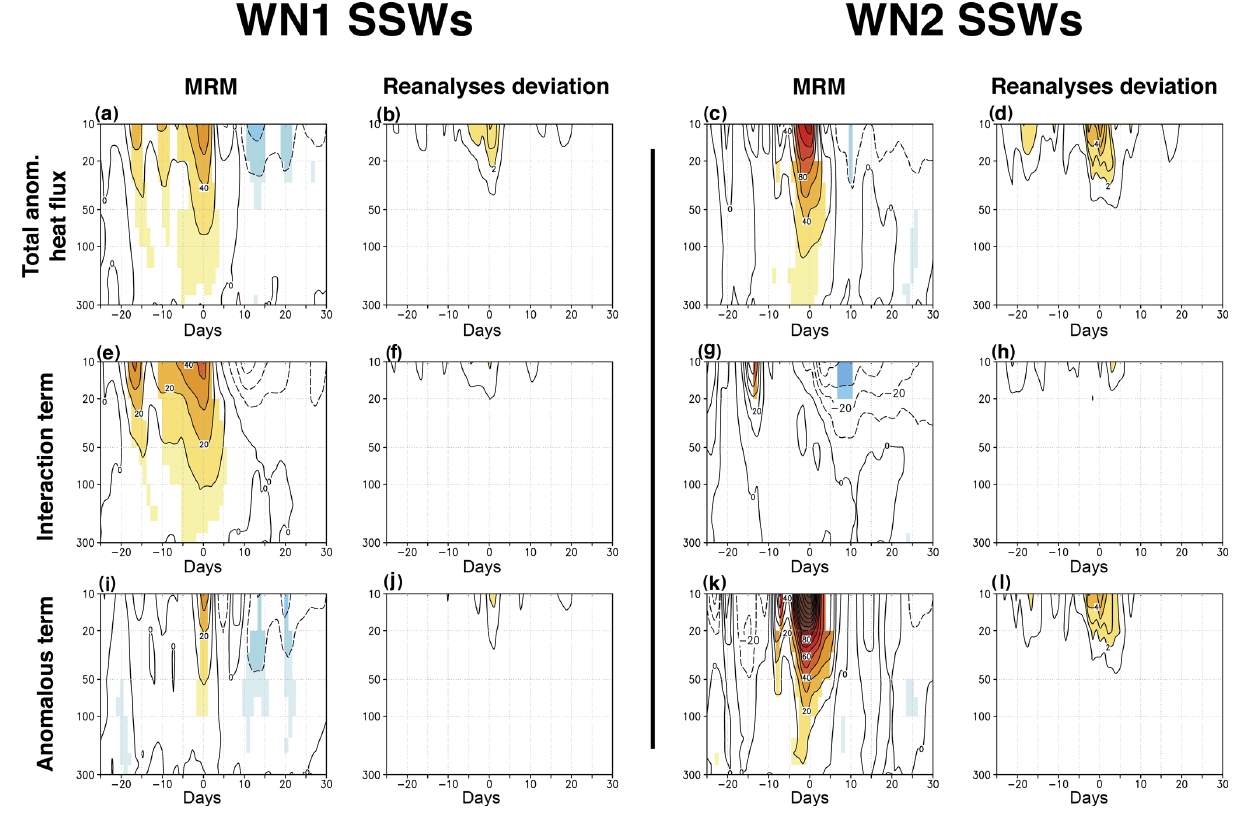
Figure 6. Same as Fig. 5 but for (a) WN1 SSWs and (b) WN2